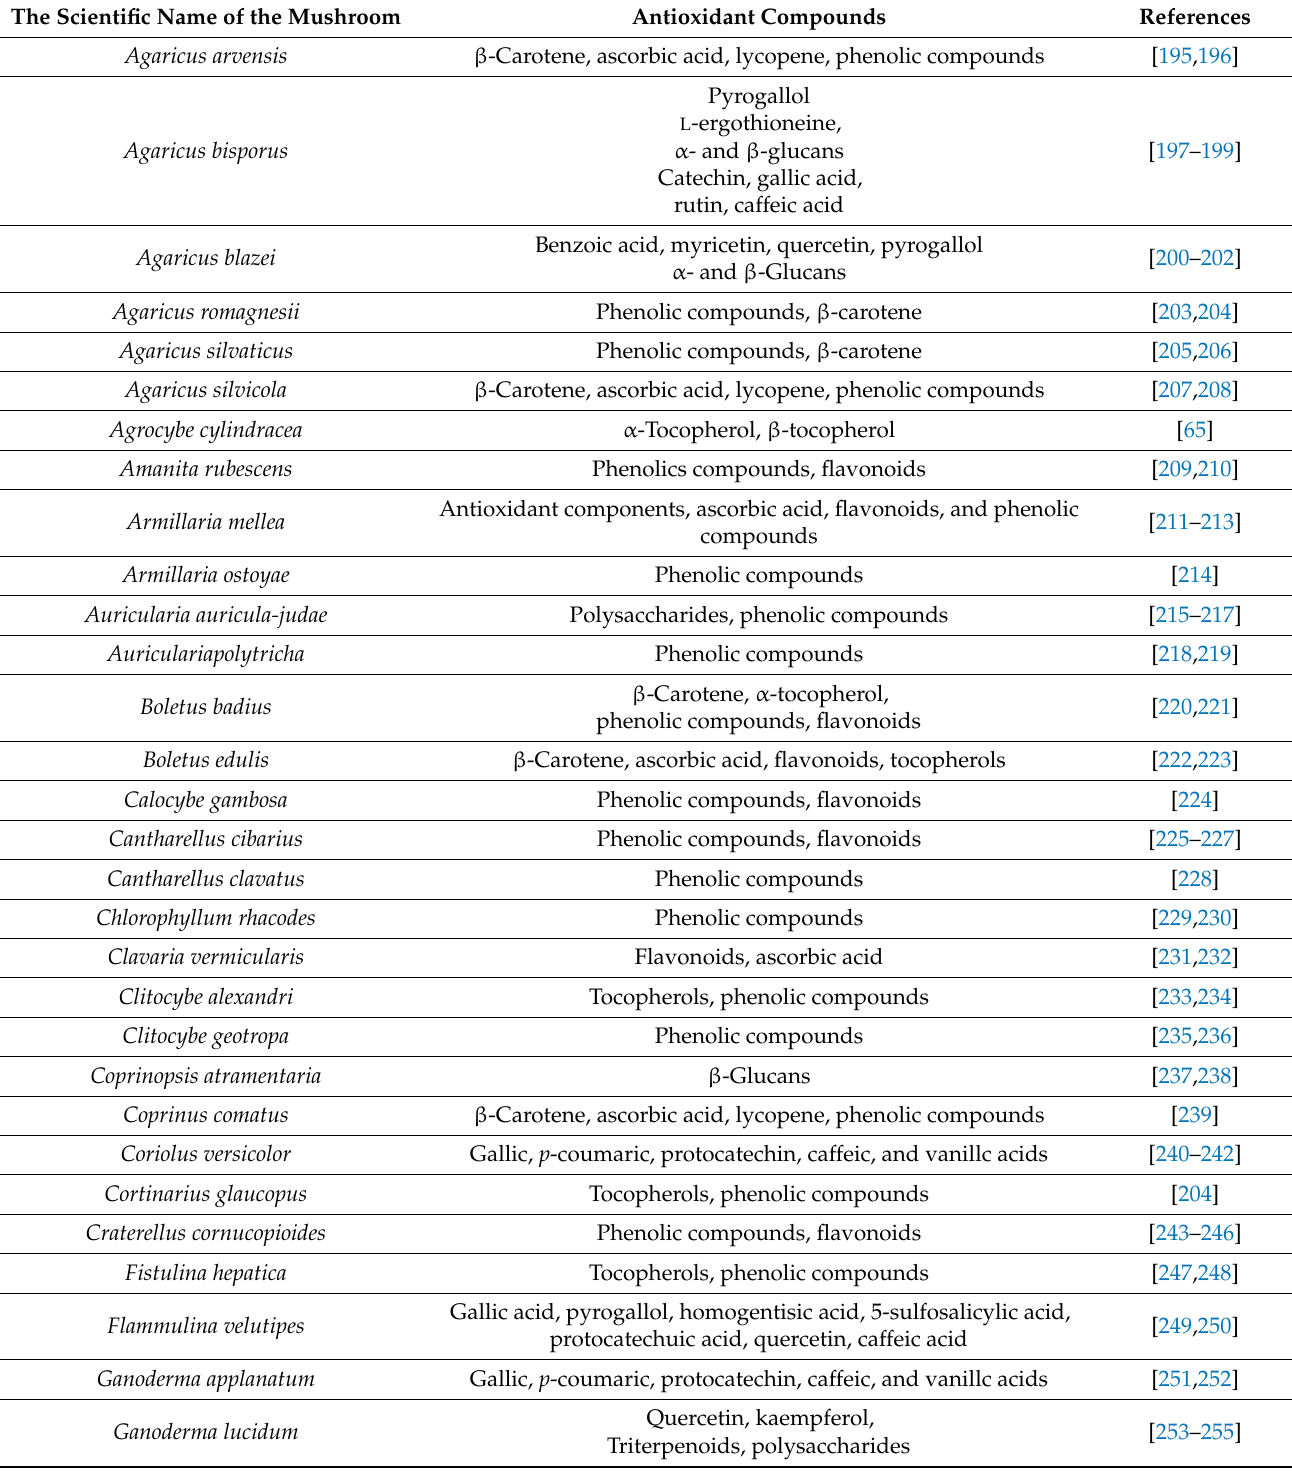
Table 5. Mushrooms and their antioxidant-derived